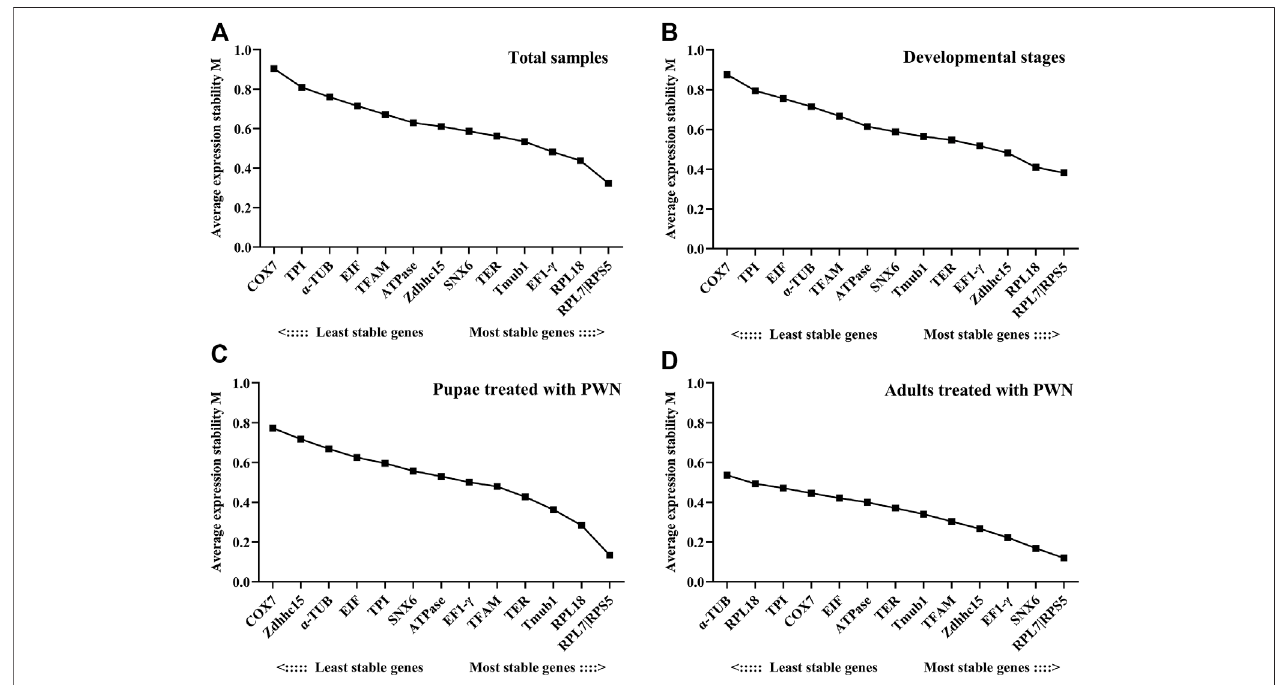
FIGURE 2 | Average expression stability and ranking of candidate reference genes calculated by geNorm. Candidate reference genes with lower M values were more stable. The least stable genes are listed on the left, and the most stable genes are listed on the right. (A) Total samples. (B) Developmental stages associated with infection of PWN. (C) Pupae treated with PWN. (D) Adults treated with